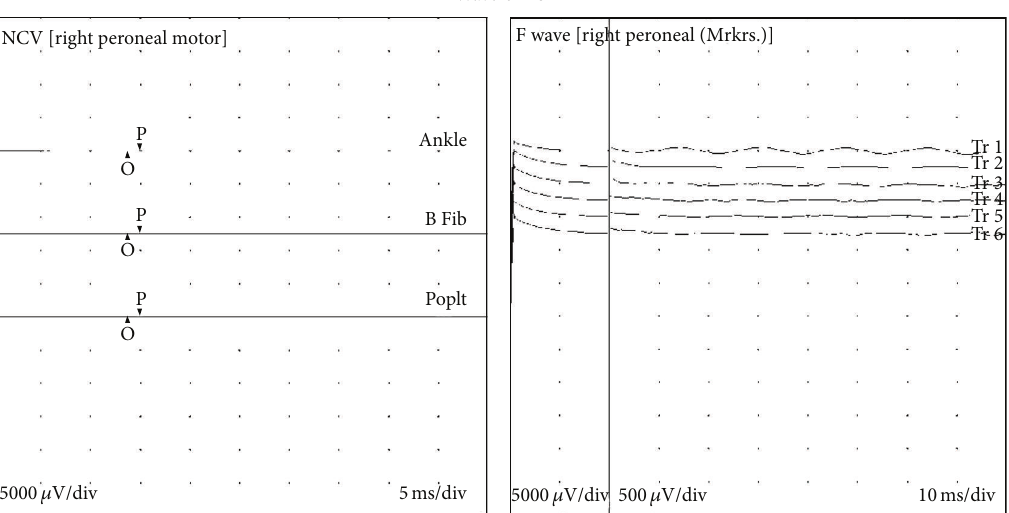
Figure 1: Nerve conduction studies (see Table 1). Findings: evaluation of the right peroneal motor nerve showed prolonged distal onset latency (13.8 ms), reduced amplitude (Ankle, 0.0 mV), reduced amplitude (B Fib., 0.0 mV), and reduced amplitude (Poplt., 0.0 mV). F wave studies indicate that the right peroneal F wave has no